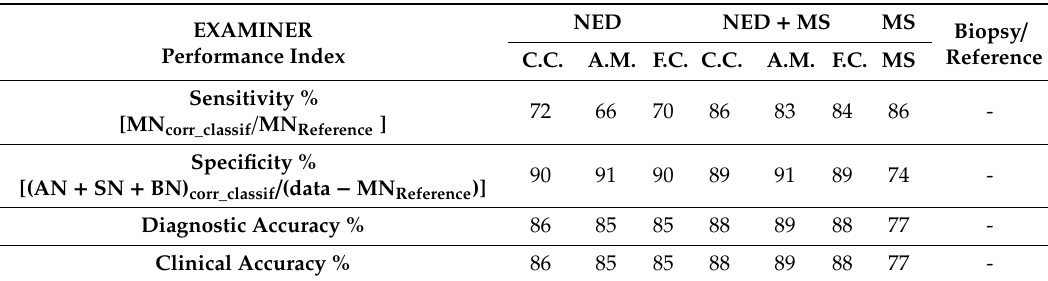
Table 8. Performance comparison of lesion classification by non-expert (NED) dermatologist group and semi-automatic approach (NED +